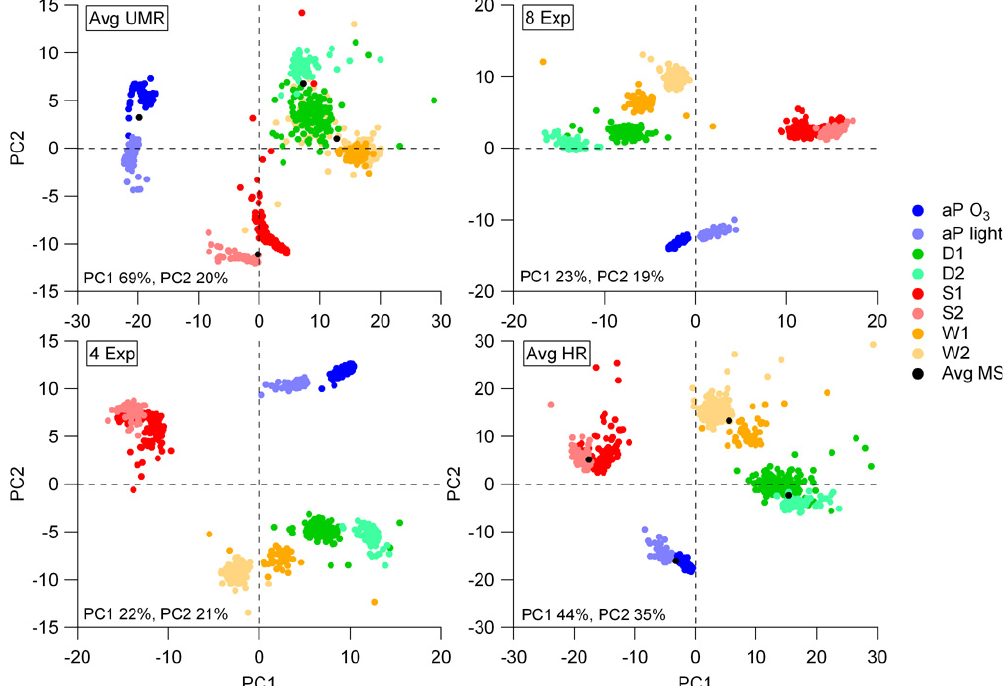
Fig. 8. Score plots of the four PCA models based on the average unit mass resolution spectra (Avg UMR), four high resolution experiments (4 Exp), all eight high resolution experiments (8 Exp) and the average high resolution spectra (Avg HR). The colored circles represent the data point from the α -pinene (aP), diesel car (D), scooter (S) and wood burning (W) experiments. The black dots represent the averaged mass spectra. The percentage of variance explained by PC1 and PC2 are shown in the